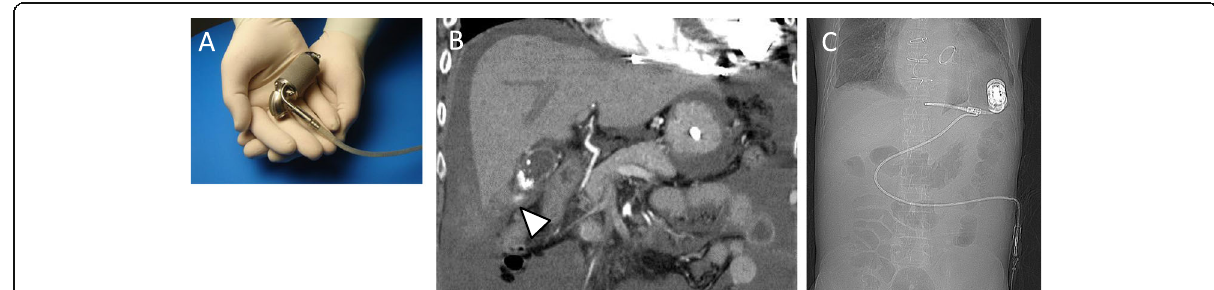
Fig. 1 Diagnostic images and a photograph of LVAD. a JarvikTM 2000. b Abdominal radiographs taken on admission showing the LVAD main body and driveline location. c Coronal computed tomography scan showing a high-density area near the gallbladder (arrowhead), high-density ascites, and gallbladder stone. There is no high-density area in the gallbladder